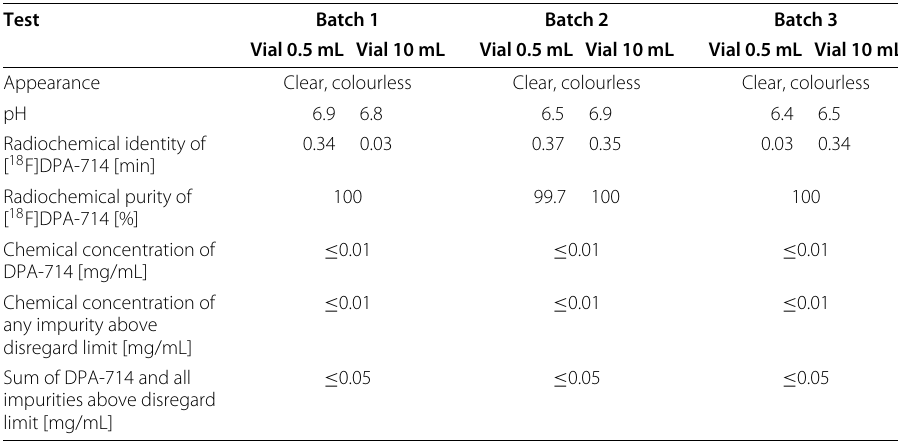
Table 6 Results of the stability study performed 6 hours post-EOS for three validation batches of [ 18 F]DPA-714. Detailed explanation of acceptance specifications can be found in Table